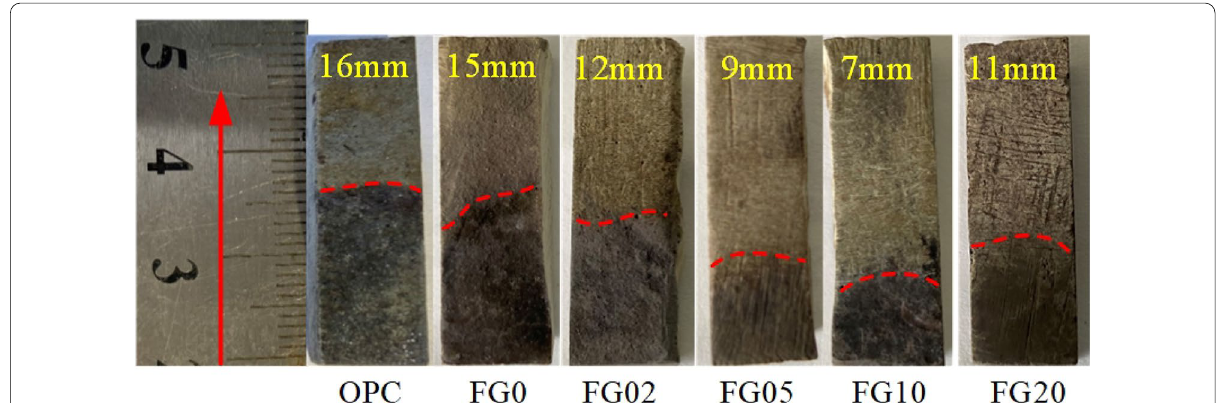
Fig. 10 The diffusion depth of chloride in the splitting surface of fly ash cement paste with different 3DG contents (from bottom to top).